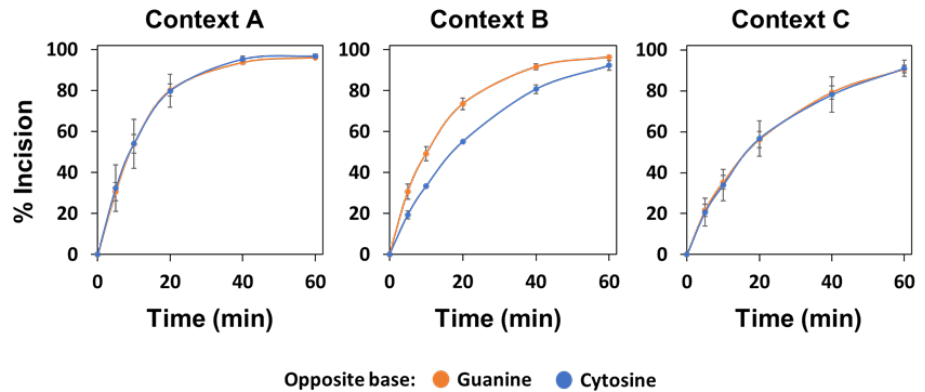
Figure 7. Effect of sequence context and base opposite the abasic site on the AP endonuclease activity of recombinant human APE1. APE1 protein (4 nM) was incubated at 37 °C with 80 nM DNA substrates (contexts A, B or C) containing an AP site opposite guanine (orange) or cytosine (blue). After stabilization with NaBH 4 , reaction products were separated by denaturing PAGE, detected by fluorescence scanning and quantified. Data are the mean and standard error from three independent experiments.